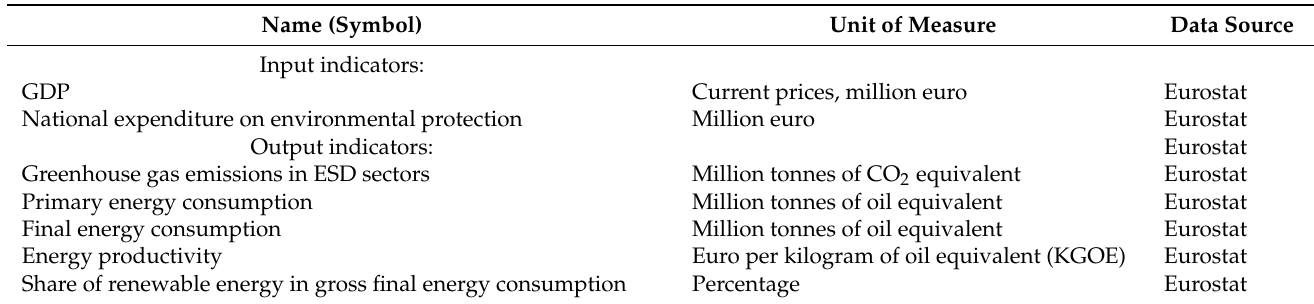
Table 2. Indicators and data